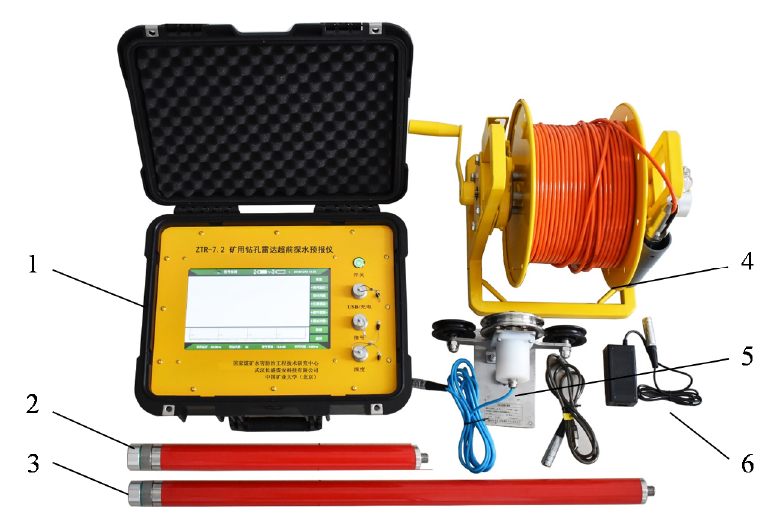
Figure 2. The single borehole ground penetration radar (GPR) prototype system. 1—computer, 2—transmitting antenna, 3—receiving antenna, 4—fiber cable, 5—depth counter, 6—charger.